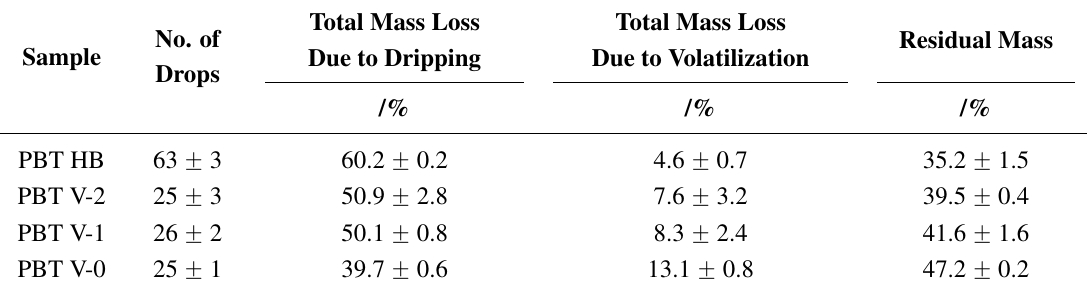
Table 4. Summary of melt dripping results for PBT HB, PBT V-2, PBT V-1 and PBT V-0 at 650 ˝